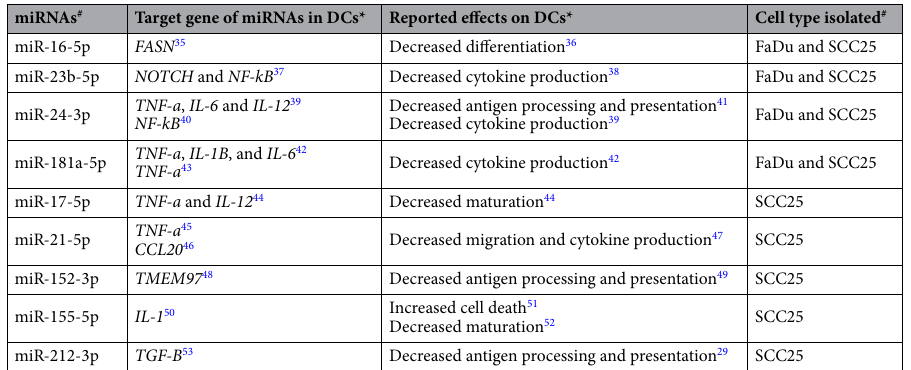
Table 3. MiRNAs detected in EVs and respective gene targets associated with immune cell function found to be down-regulated in DCs treated with EVs. Target genes reported here were studied in monocytes and/or dendritic cells according to references included in this table. # Reported in this work. *Reported in this work and